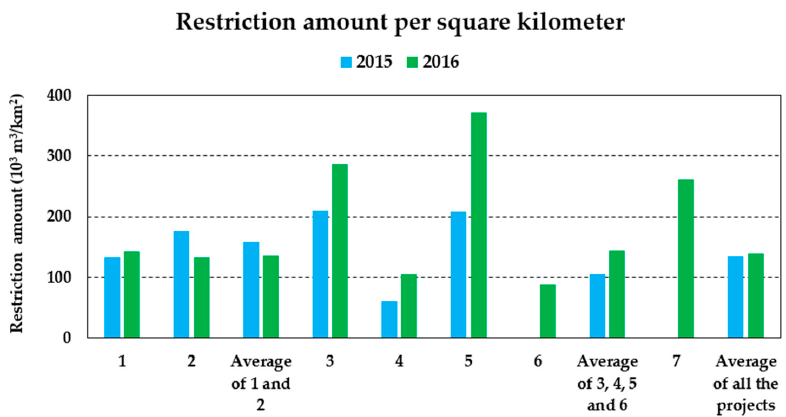
Figure 7. Restriction amount per square kilometer under normal flow conditions in the project regions (thousand m 3 ). The project numbers are the same as mentioned